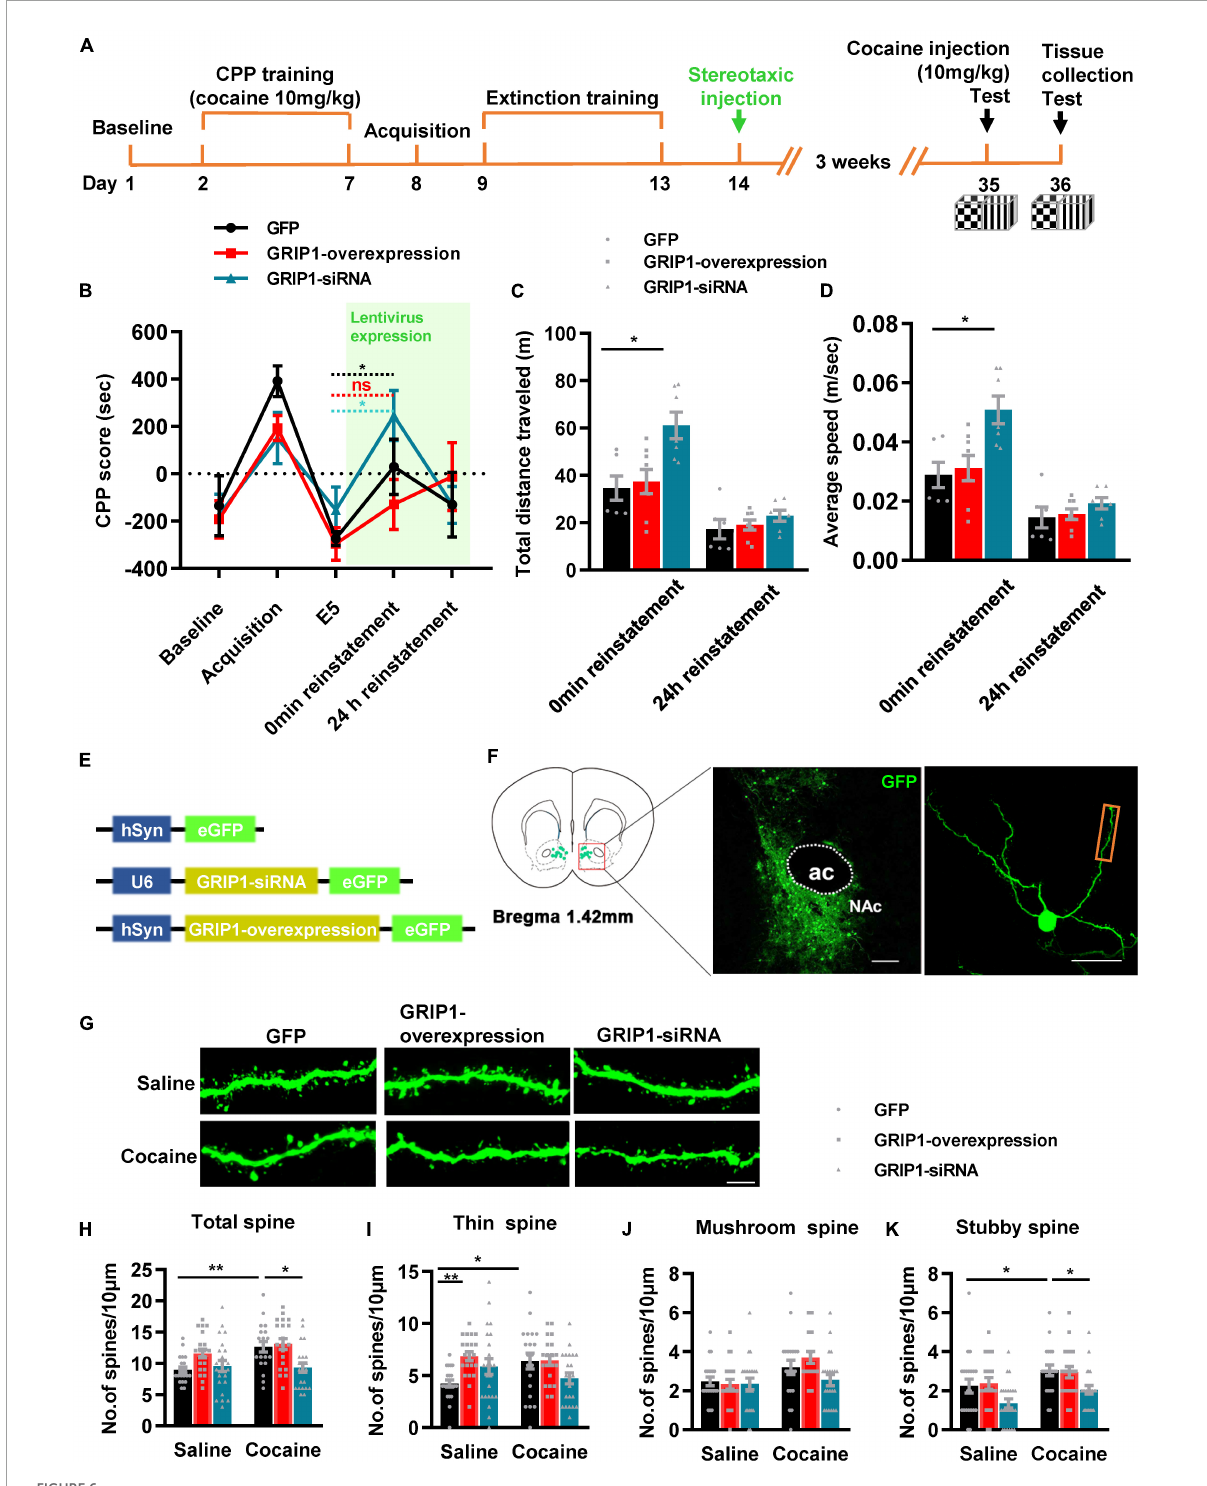
FIGURE6 GRIP1 interference enhances cocaine reinstatement but blocks associated spine plasticity. (A) Experimental design for the behavioral tests and spine analysis. Two-compartment unbiased CPP models were used. (B) GRIP1-siRNA enhanced reinstatement to cocaine place preference, while the GRIP1-overexpression group and the GFP control did not exhibit cocaine reinstatement in the unbiased CPP test. (C,D) Total distance traveled and average speed during 0 min reinstatement. (E) Viral vectors used to interfere with the expression of GRIP1. (F) Representative images of the injection site (left) and spine densities on terminal dendrites (right). (G) Representative images of GFP-labeled dendrites. (H–K) The statistical data for stubby spine, mushroom spine, thin spine, and total spine density. n = 20–30 dendrites obtained from 8–10 mice per group. * P < 0.05, ** P < 0.01, and *** P <